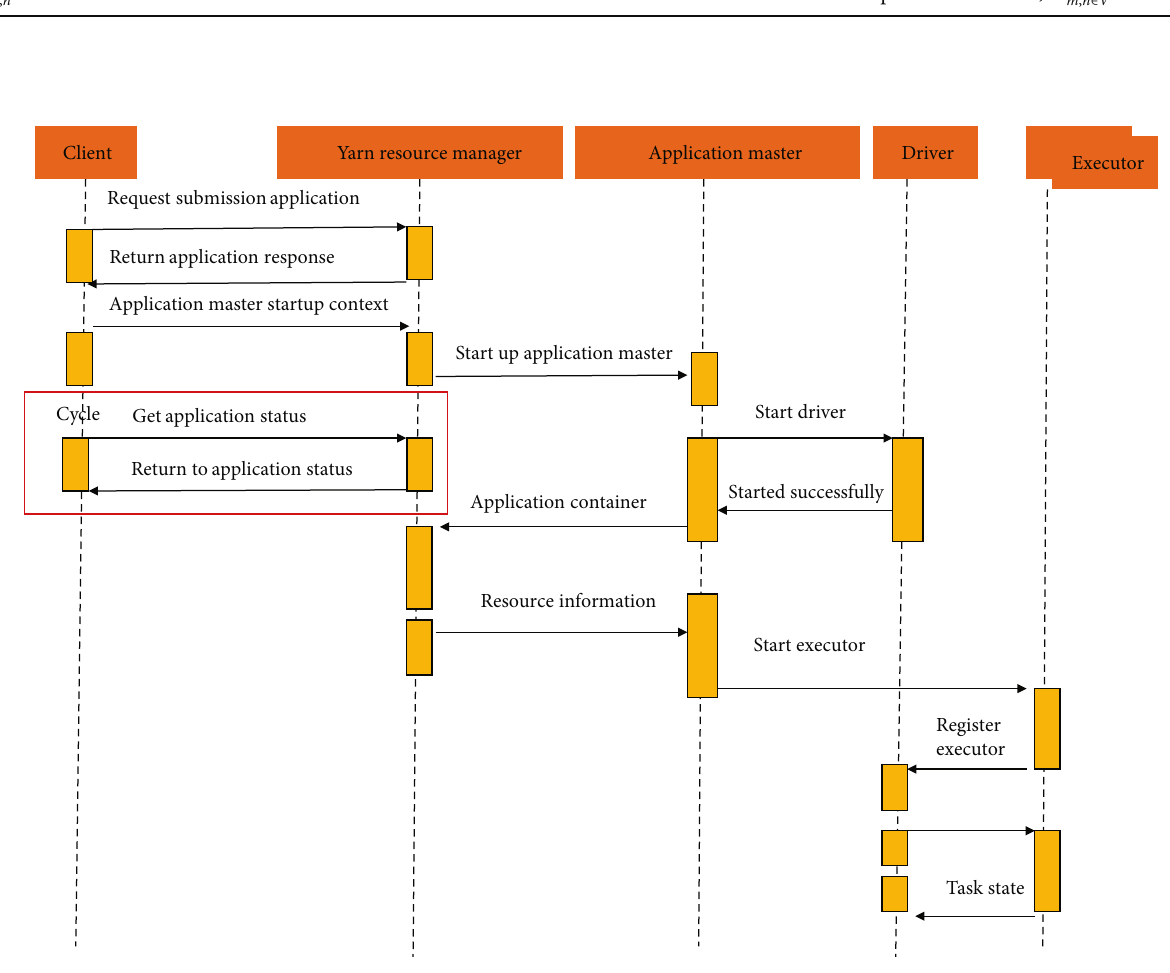
Figure 3: Spark task scheduling sequence